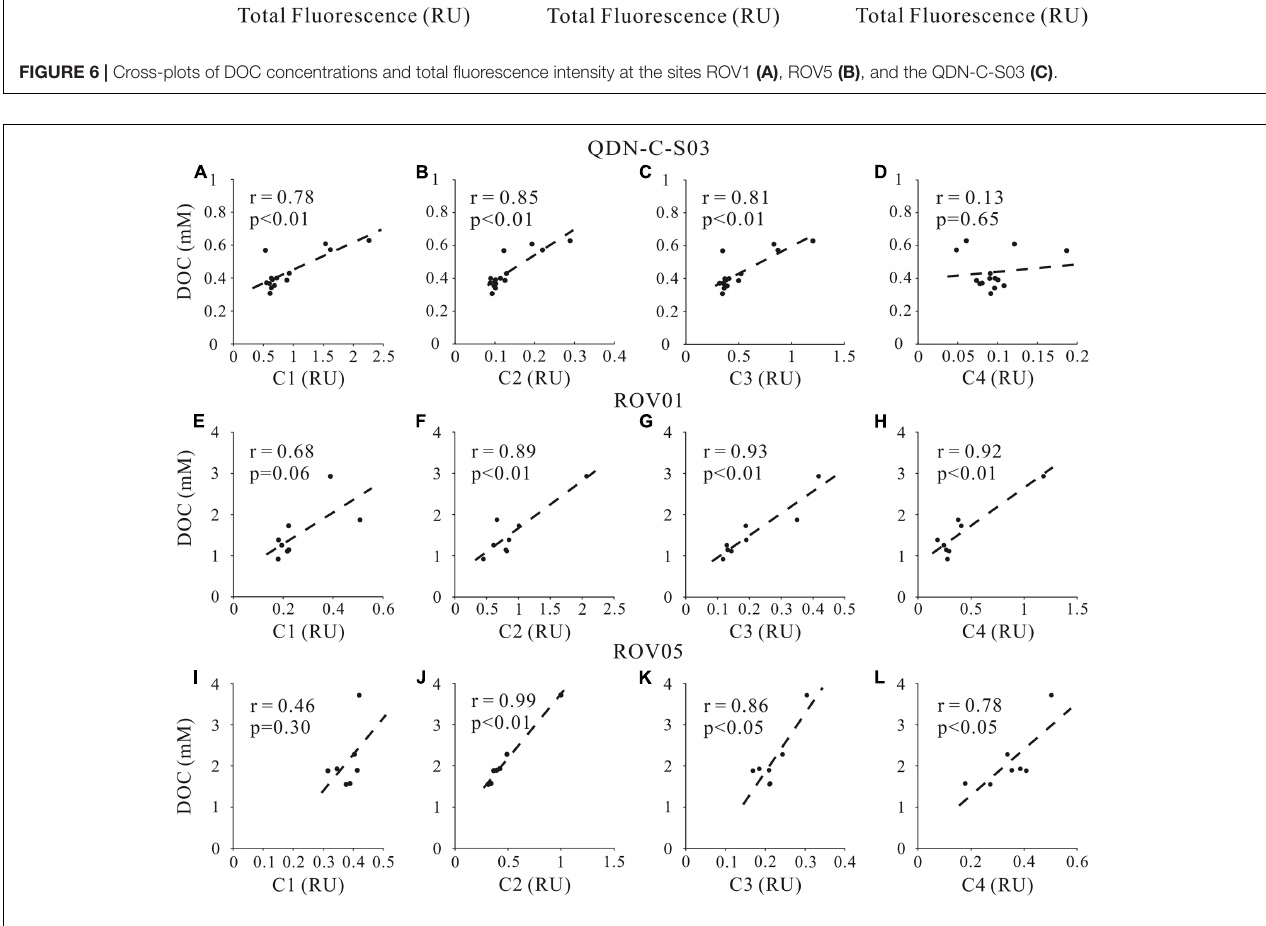
FIGURE 7 | Cross-plots of DOC concentrations and fluorescent intensity of FDOM components (C1, C2, C3, and C4) at cores QDN-C-S03 (A–D) , ROV1 (E–H) and ROV5 (I–L)